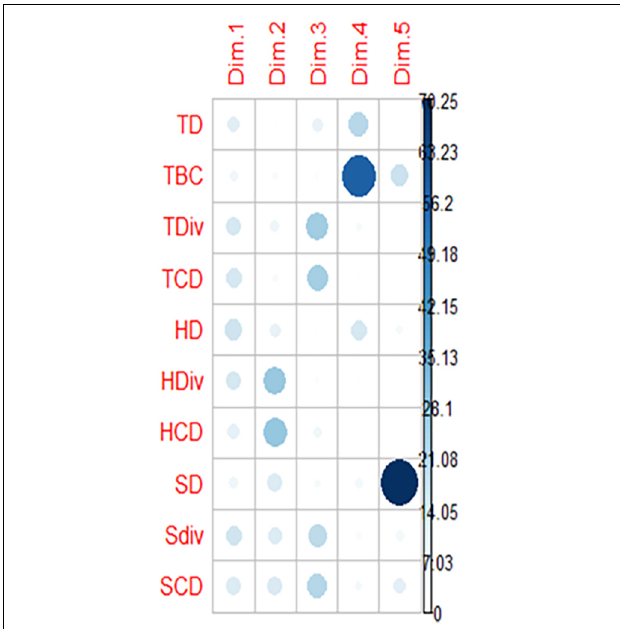
FIGURE 6 | Loading contribution by different variables at various axis. TD, Tree density; TDiv, Tree diversity; TBC, Tree basal cover; TCD, Tree concentration of dominances; SD, Shrubs density; SDiv, Shrubs diversity; SCD, Shrubs concentration of dominance; HD, Herbs density; HDiv, Herbs diversity; HCD, Herbs concentration of dominance.